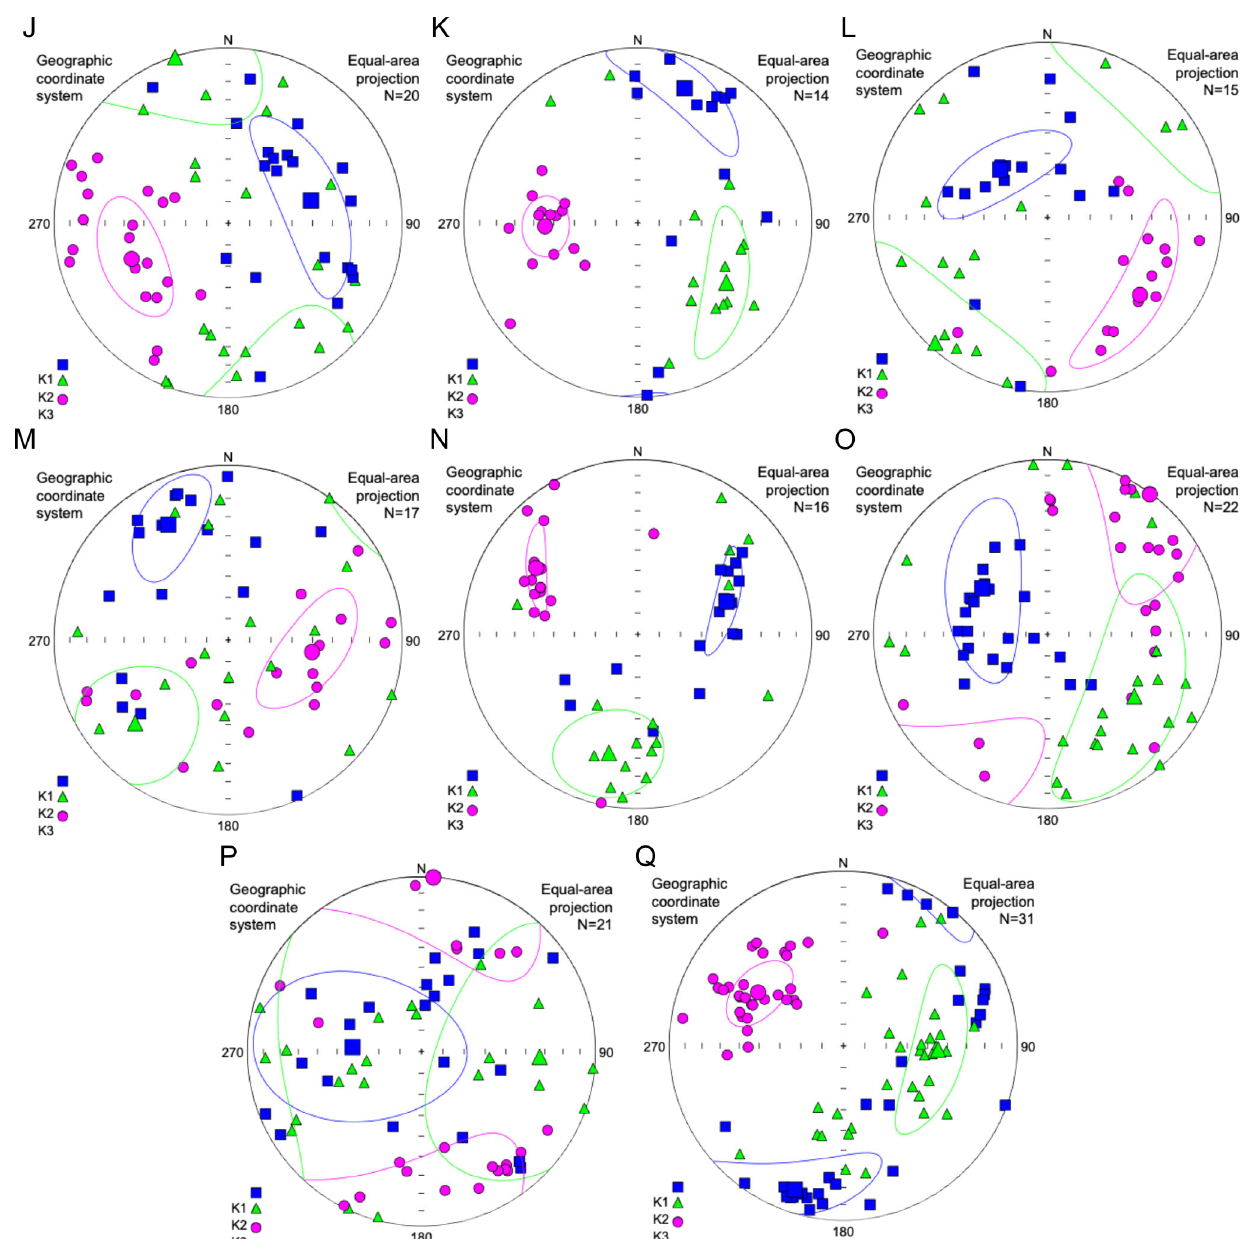
Figure A1: [cont.]: Anisotropy of Magnetic Susceptibility results for [J] PDD10; [K] PDD11; [L] PDD12; [M] PDD13; [N] PDD14; [O] PDD15; [P] PDD16; [Q]